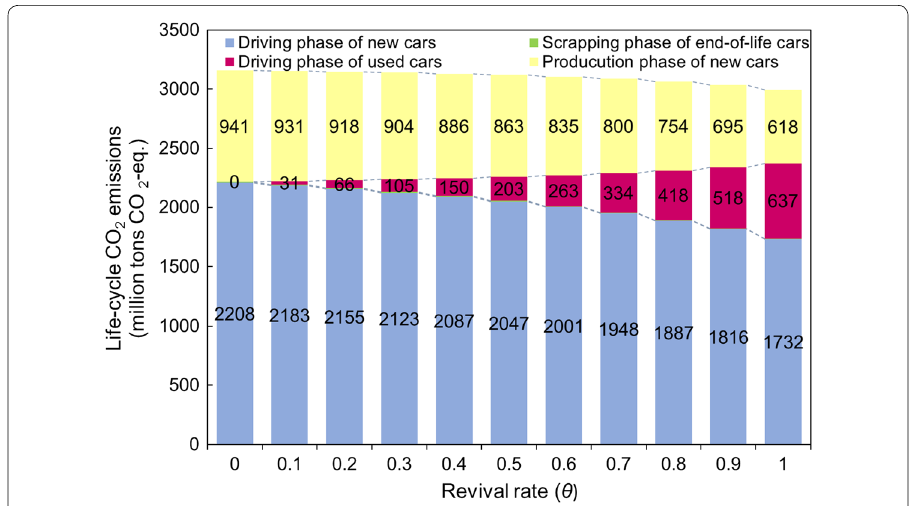
Fig. 4 Cumulative life-cycle CO 2 emissions of new and used cars registered during 1993–2013 under revival scenarios (benchmark: θ 0.4, Δ μ = =